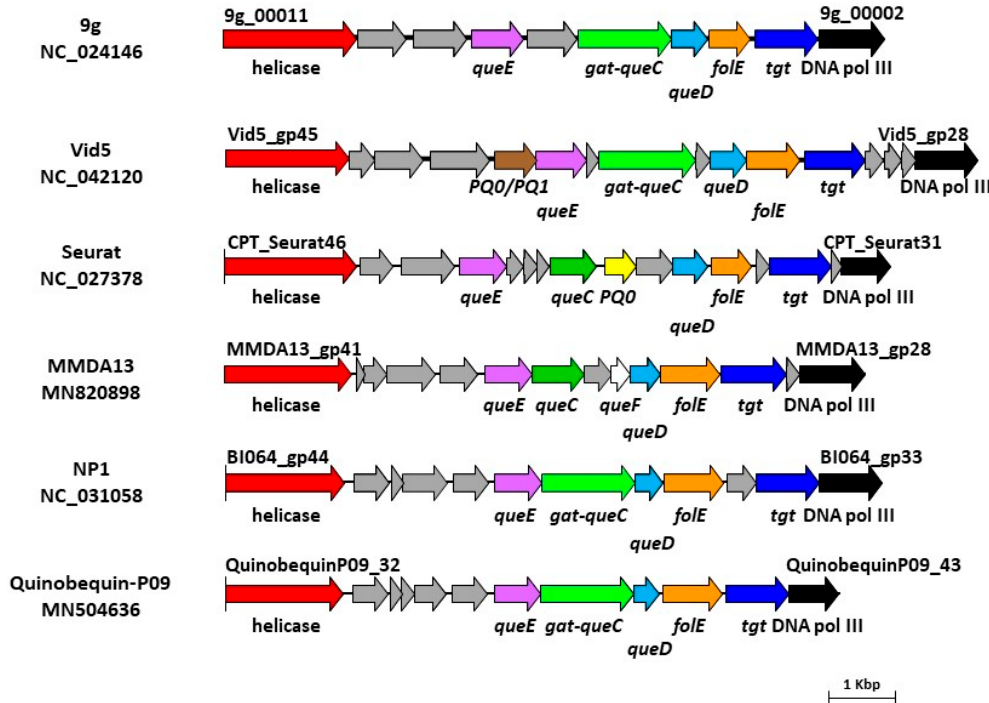
Figure 4. Gene clusters involved in the biosynthesis of 7-deazaguanine derivatives in